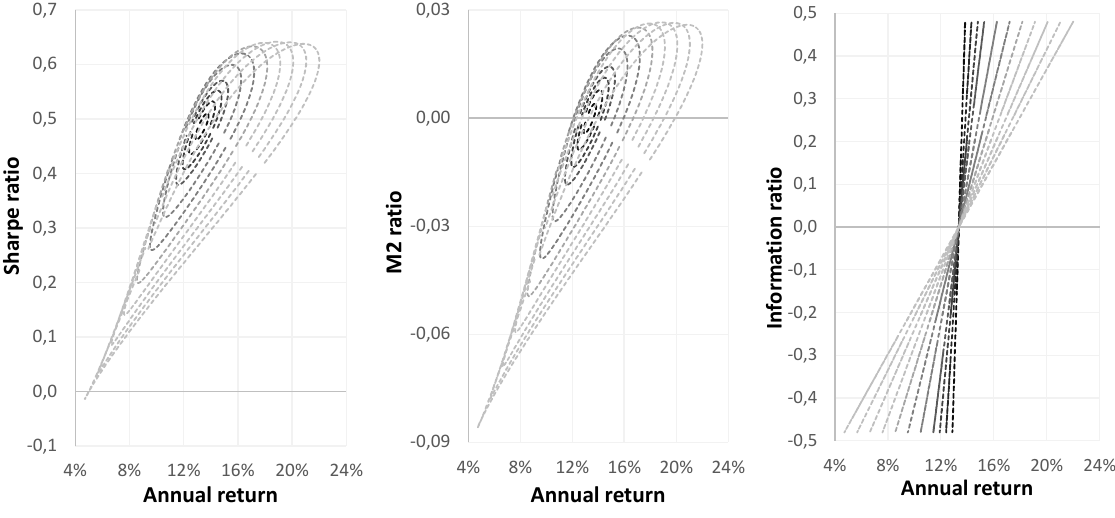
Figure 9. The loci of possible (a) Sharpe ratios, (b) M 2 ratios and (c) IRs – as a function of portfolio return – for increasing TE s